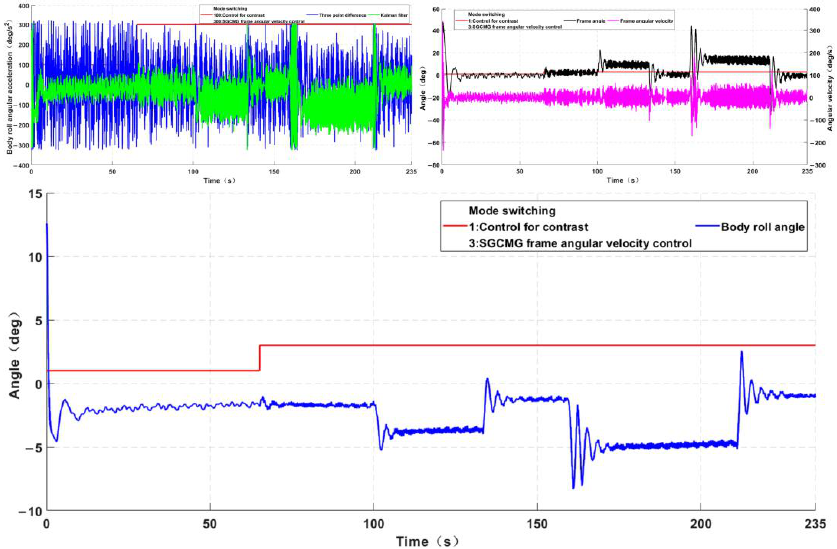
Figure 25. Experimental results: Load test of the SGCMG frame angular velocity controller.